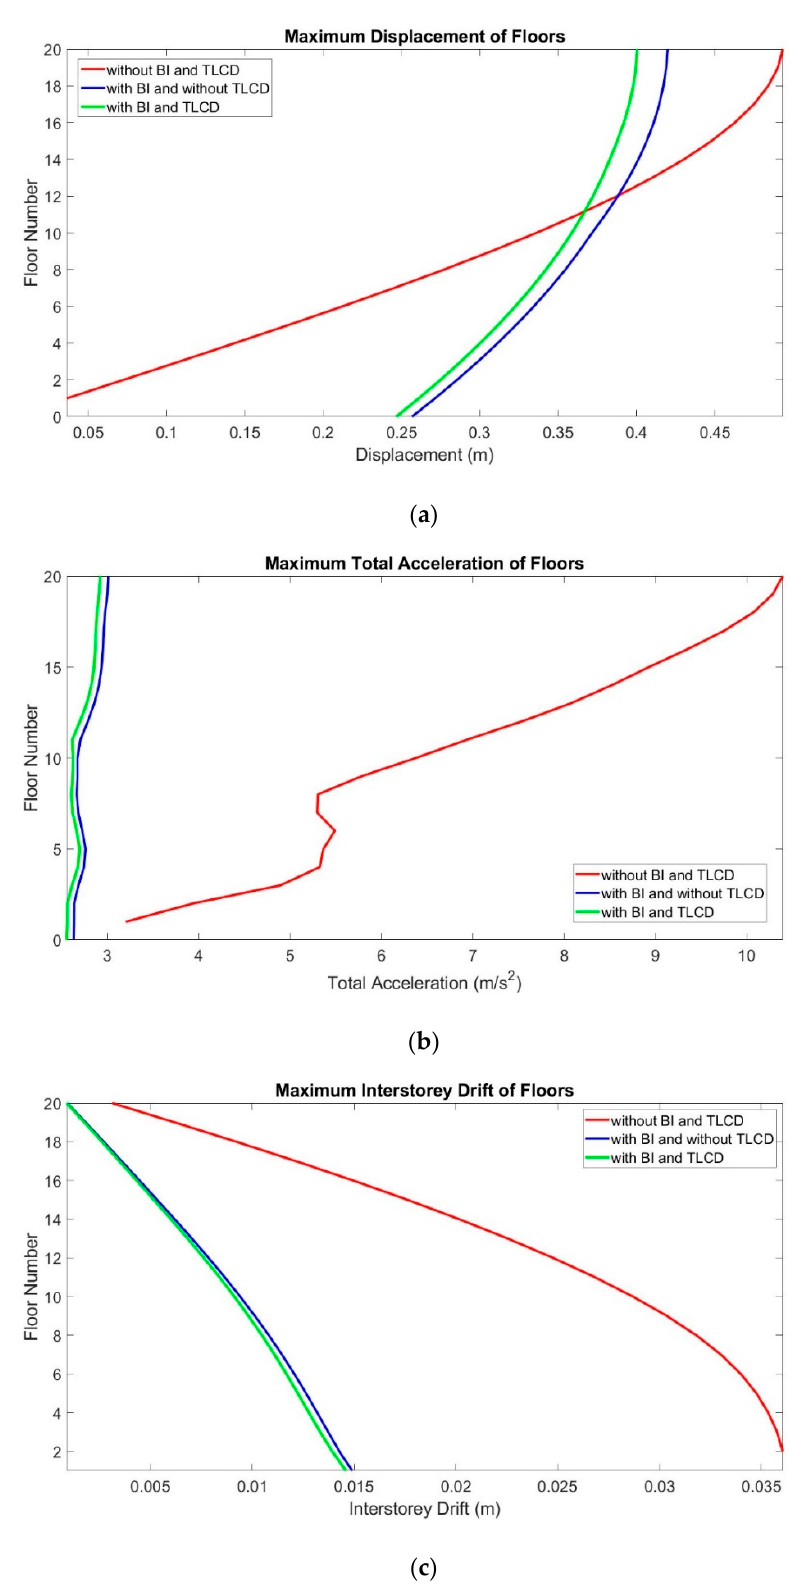
Figure 3. Peak response profiles for hybrid-controlled structure, base-isolated structure, and simple uncontrolled structure subjected to earthquake no. 37 record: ( a ) maximum displacement; ( b ) maximum total acceleration; ( c ) maximum interstory drift.